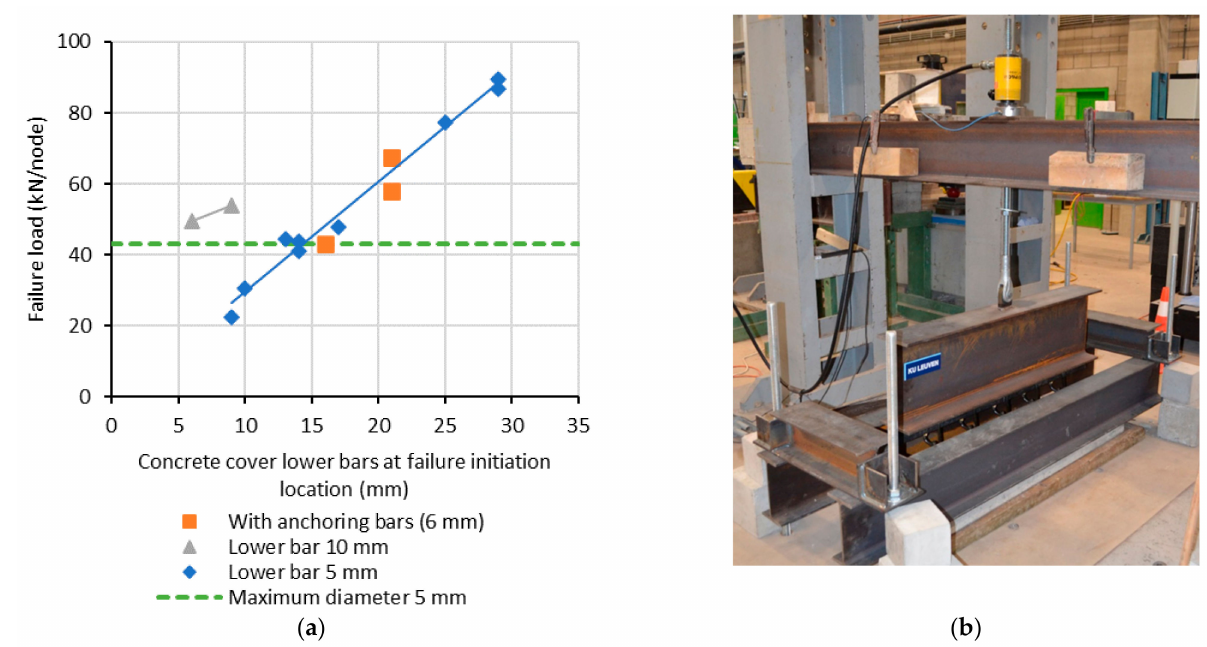
Figure 16. Pull-out tests on lattice girders: ( a ) results; ( b ) test